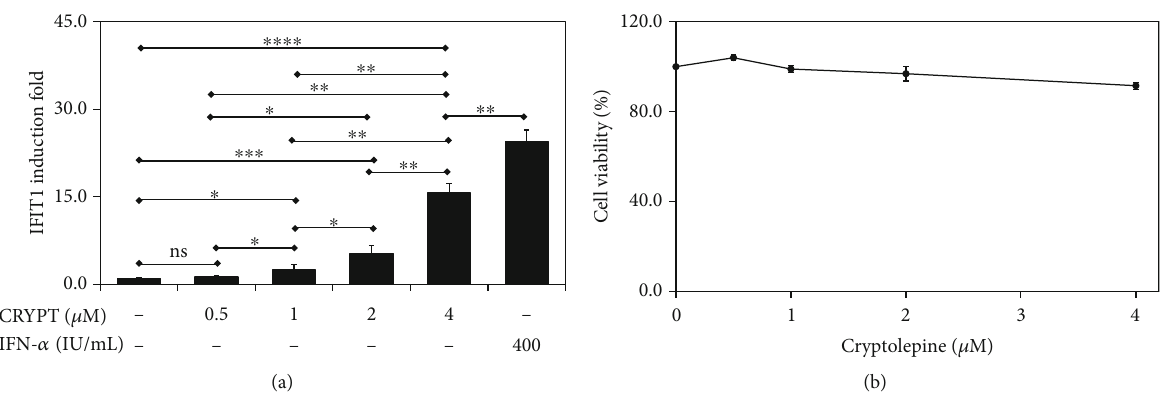
Figure 1: Cryptolepine activates IFN-1 response in THP1-derived macrophages. The derived macrophages from the parent THP1 cells were cultured with 0.5 – 4 μ M cryptolepine (CRYPT). IFN- α (400IU/mL) was employed as an experimental positive control. The IFIT1 induction (a), as well as cell viability (b), was evaluated after 24h. Data are shown as the means, from three varied experiments with each done in triplicate, and error bars represent the standard deviations. ∗ p < 0 : 05 , ∗∗ p < 0 : 01 , ∗∗∗ p < 0 : 001 , and ∗∗∗∗ p < 0 : 0001 ; ns: di ff erence not signi fi cant (one-way ANOVA and Bonferroni ’ s